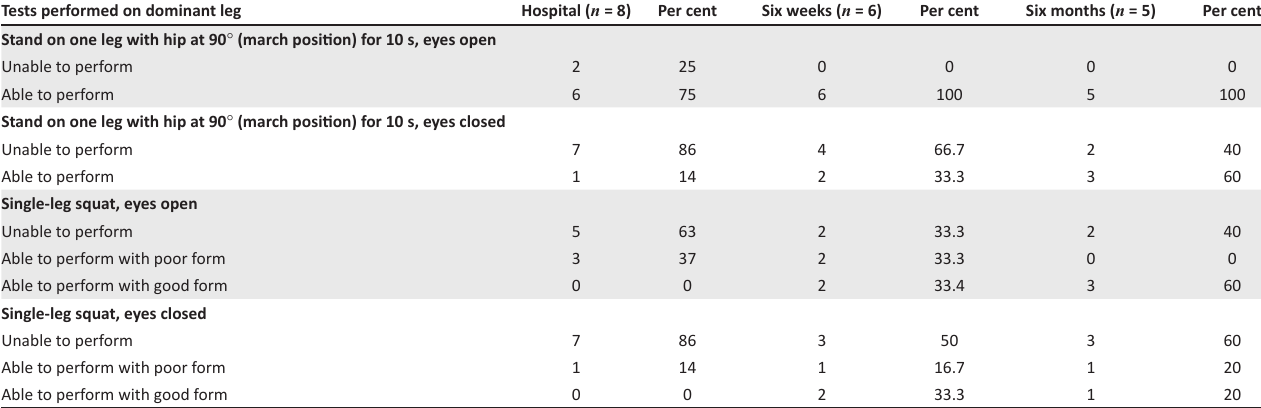
TABLE 3: Additional balance test results with eyes open and eyes closed. Tests performed on dominant